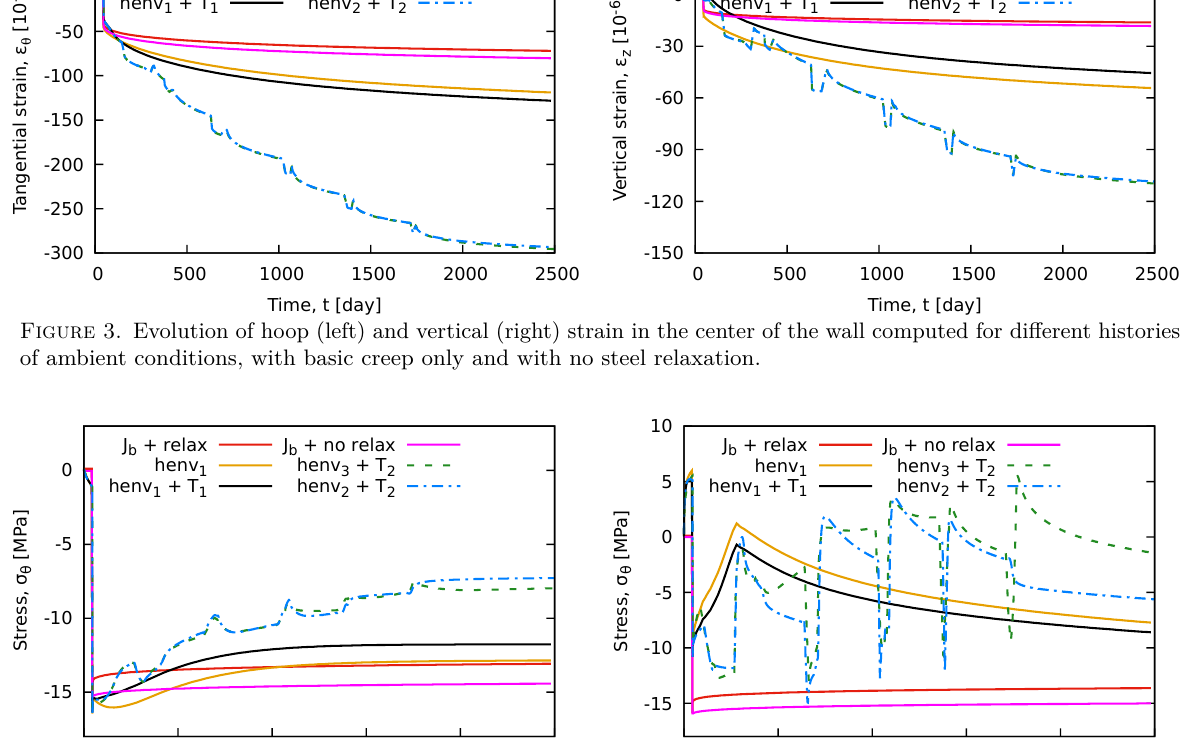
in the middle (left) and close to the inner surface (right) of the CCB concrete θ